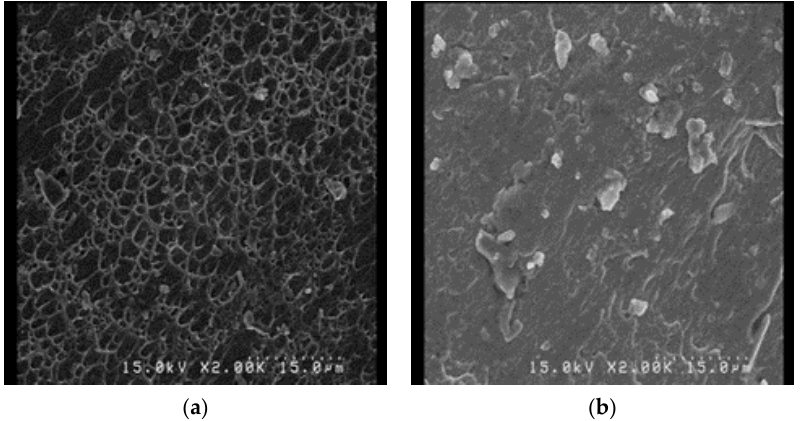
Figure 5. Typical fracture surface according to ductility and brittleness. ( a ) Ductile fracture; ( b ) brittle fracture.